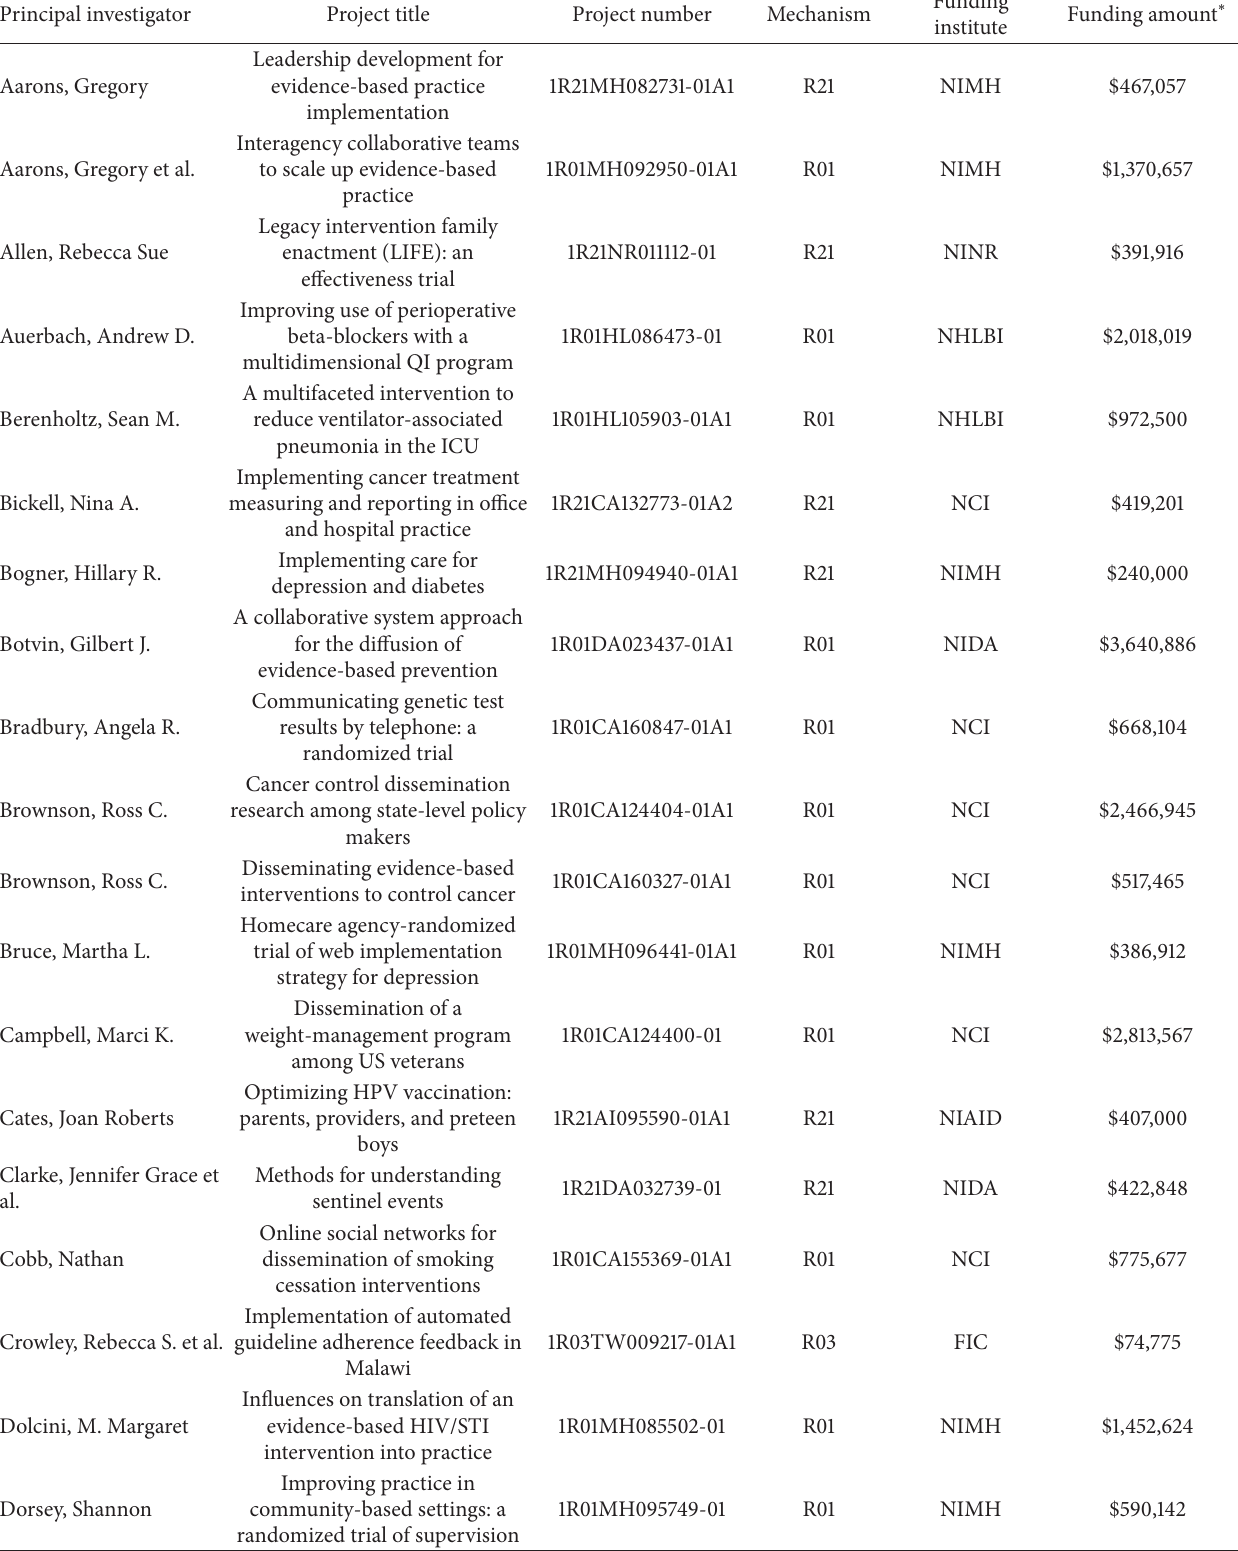
Table 6: Abstracts evaluated in the